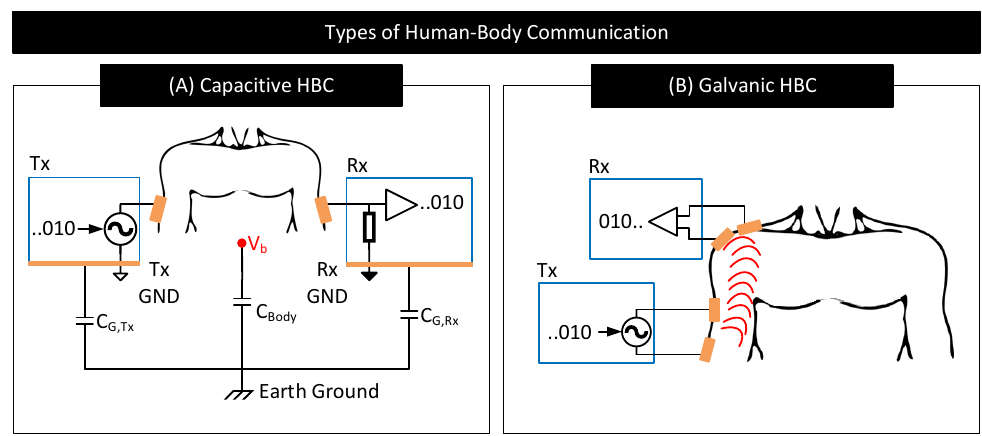
Figure 17. Simplified schematic of ( A ) capacitive HBC and ( B ) galvanic